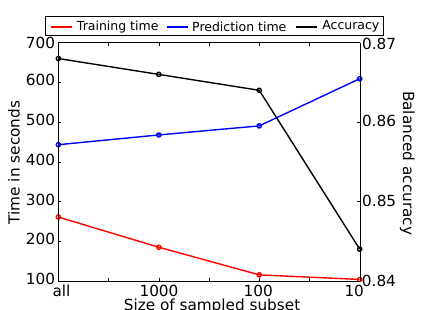
Figure 7. Influence on computation time and accuracy by subsampling.